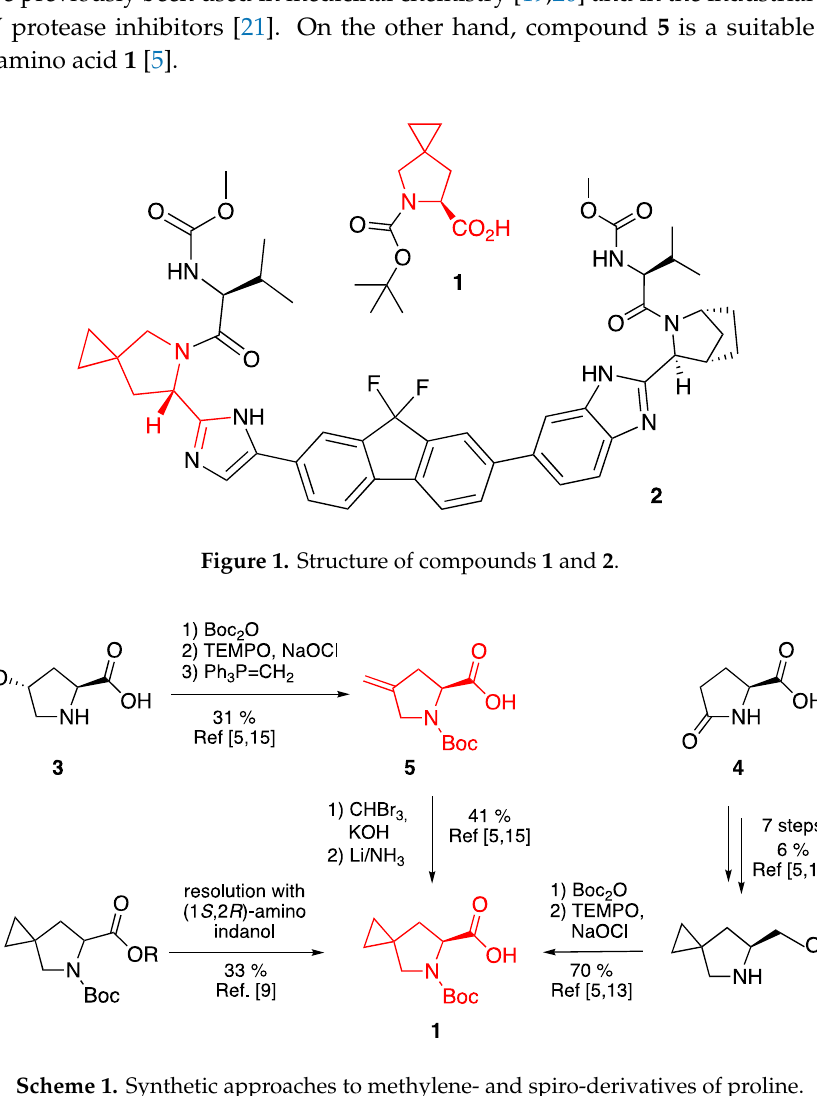
Figure 1. Structure of compounds 1 and